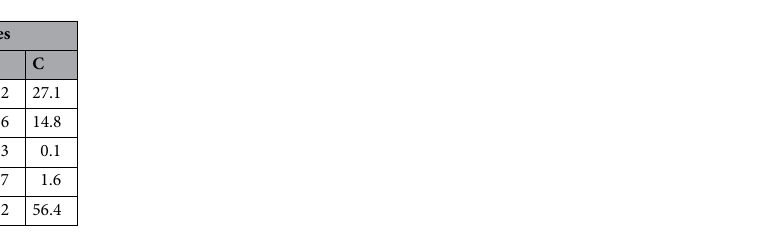
Table 8. Results of cluster and outlier analysis, for individual maps, described in Step 5 ( cf. Section 3). The number represents the